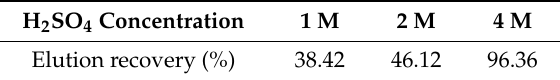
Table 9. Elution